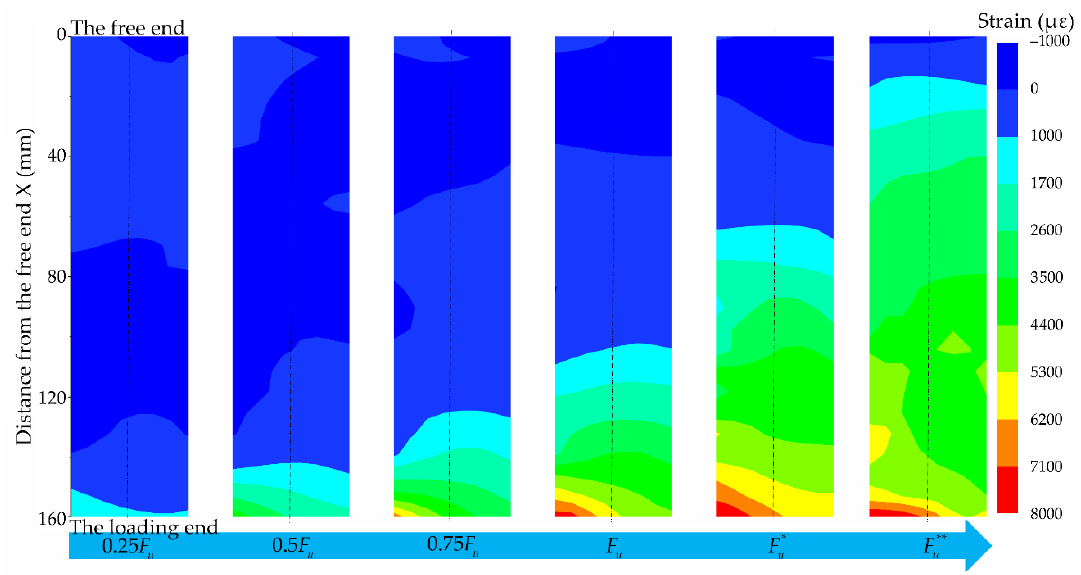
Figure 6. The strain contours of specimen B2. The strain on the median line marked in Figure 6 was extracted. The strain distribution data and the fitted curves of specimen A4 and B2 are shown in Figure 7a,b, respectively.